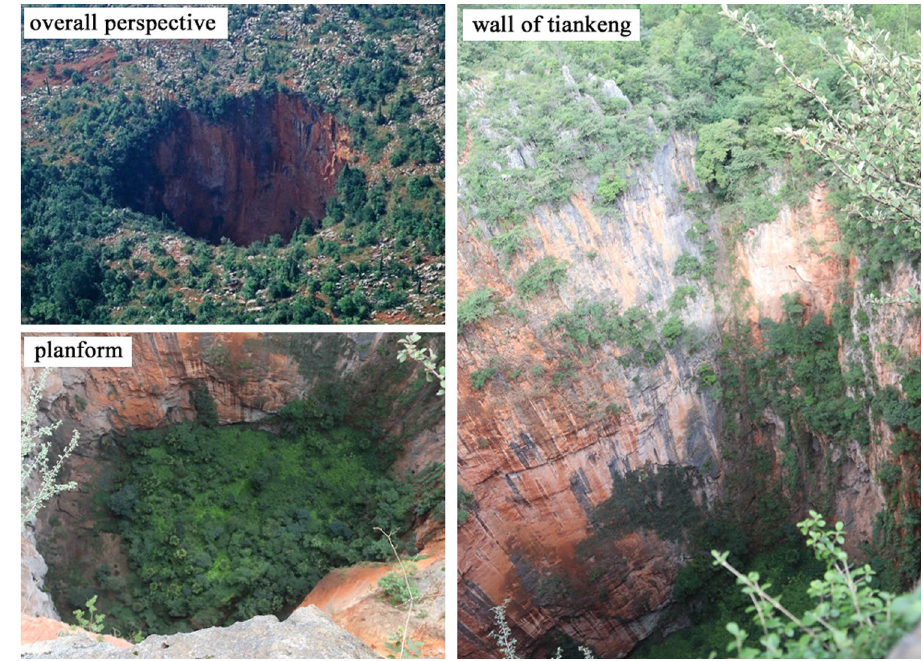
Figure 7. Panorama and profile map of